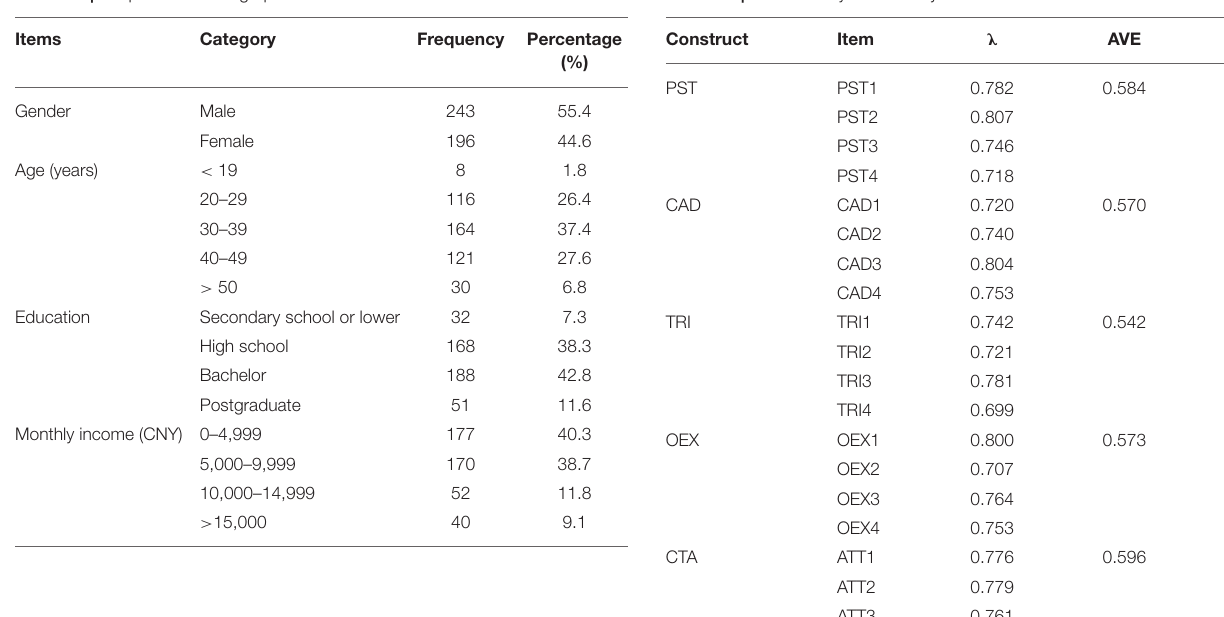
TABLE 2 | Respondent demographics. TABLE 3 | Confirmatory factor analysis